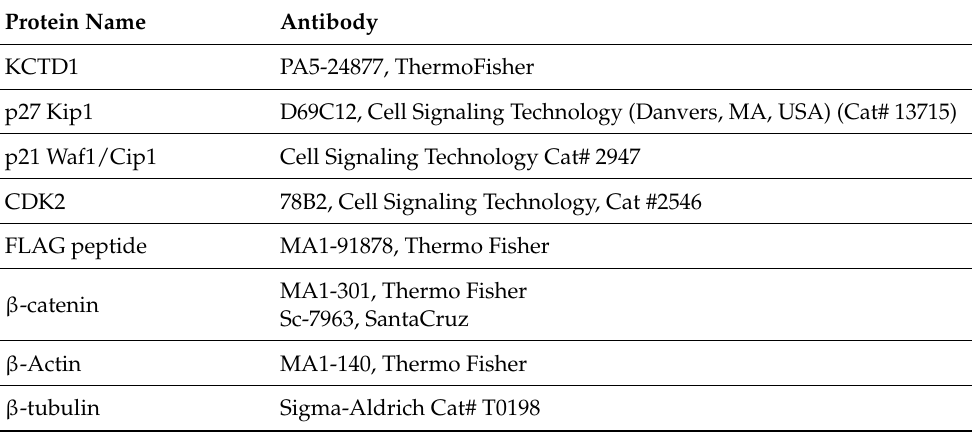
Table 2. Antibodies used for western blot